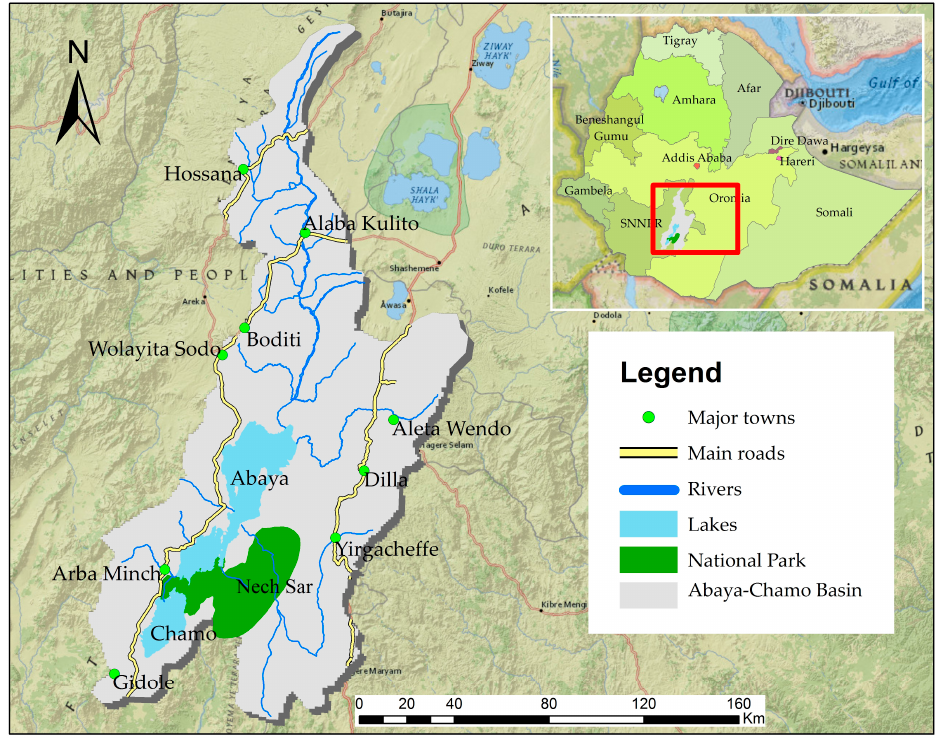
Figure 1. Map of the study area.